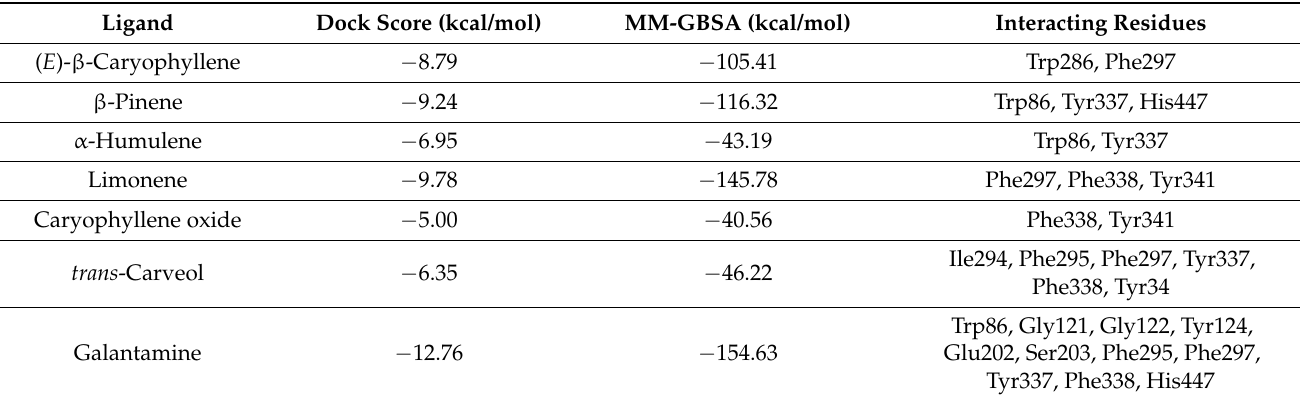
Table 6. Dock score and MM-GBSA estimation and residue interactions of the studied compounds against AChE enzyme.